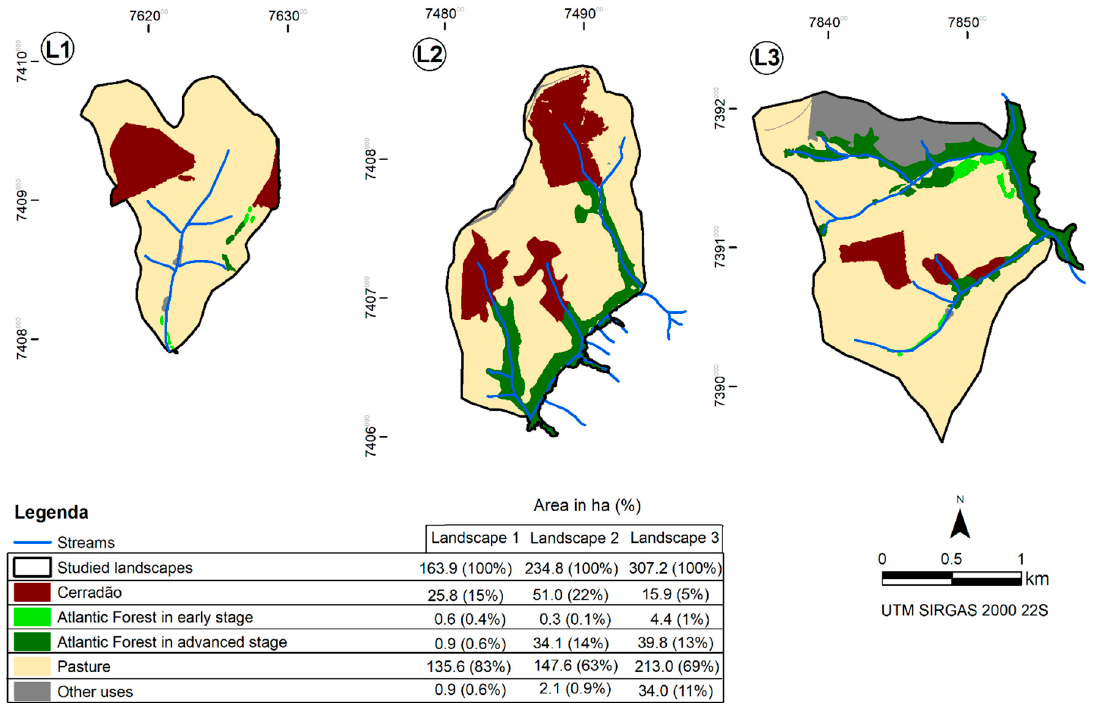
Figure 2. Land use and land cover of the three studied landscapes, with the occupied areas in hectares (ha) and percentages (%).